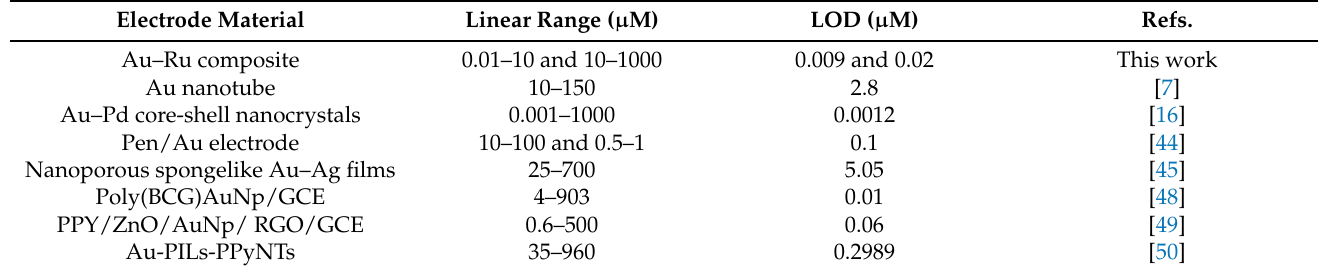
Table 2. Comparison of the electrochemical performances of different epinephrine